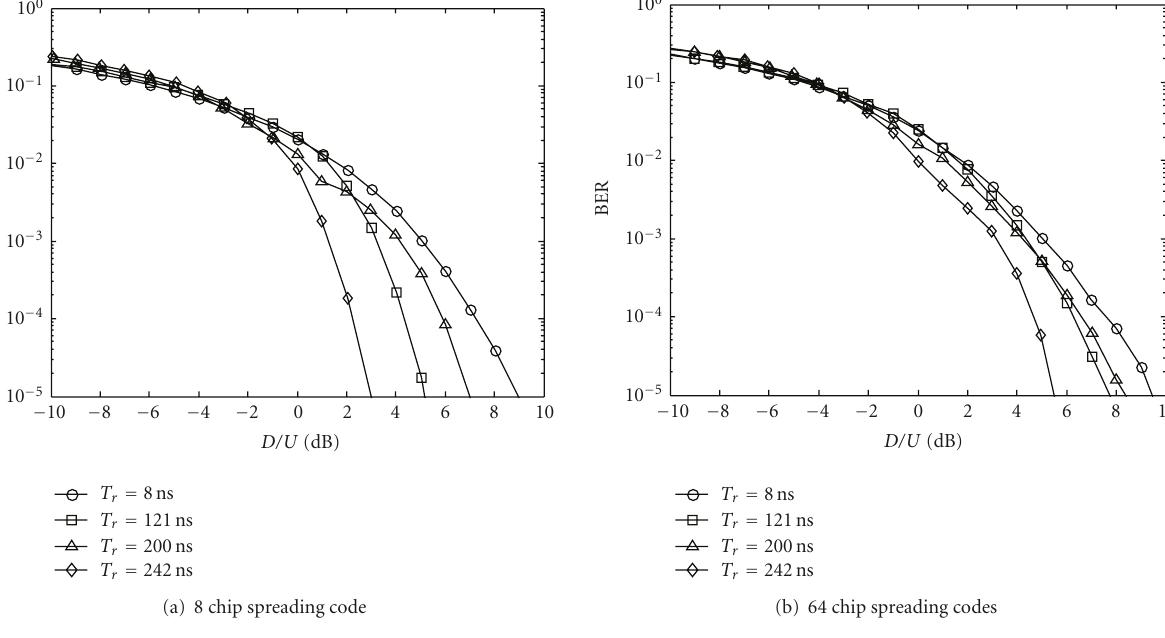
spreading codes. The characteristics of the BER performance are almost the same as Figure 2(a). When the symbol repetition interval is equal to or half of the OFDM IFFT/FFT period, the BER performance improves the same extent as the p-UWB paired with an OFDM